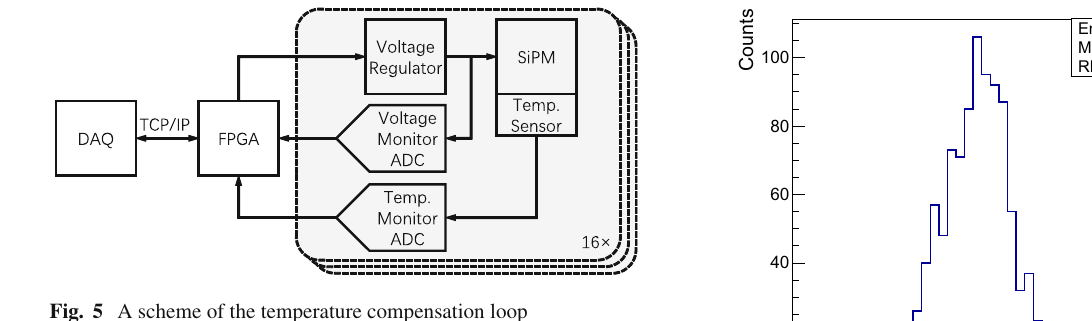
Fig. 5 A scheme of the temperature compensation loop